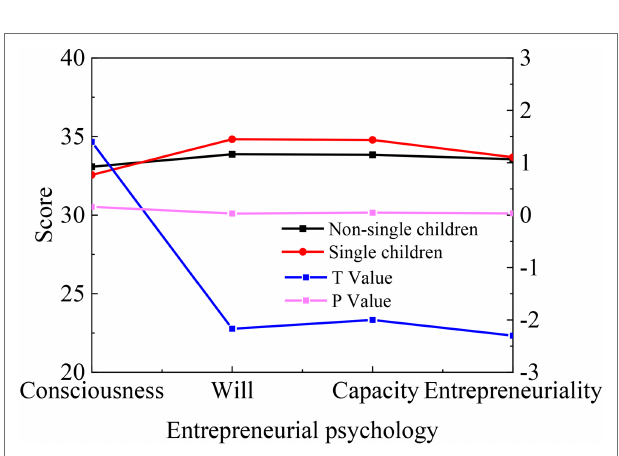
FIGURE 5 | Statistics on the difference of College Students’ entrepreneurial psychology between only-child and non-only-child.